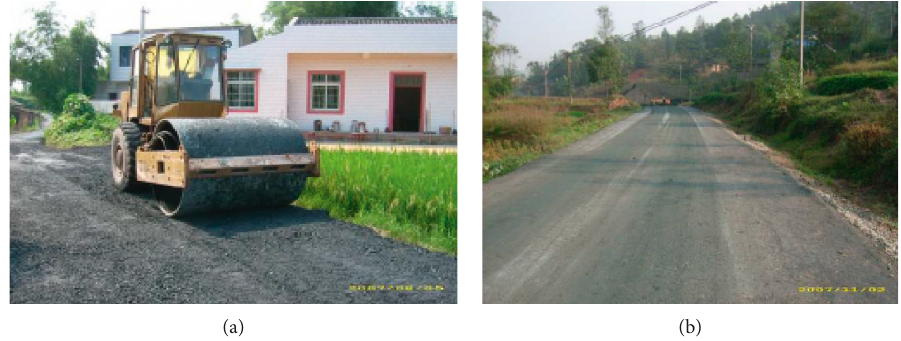
Figure 19: Base layer compaction (a) and after compaction